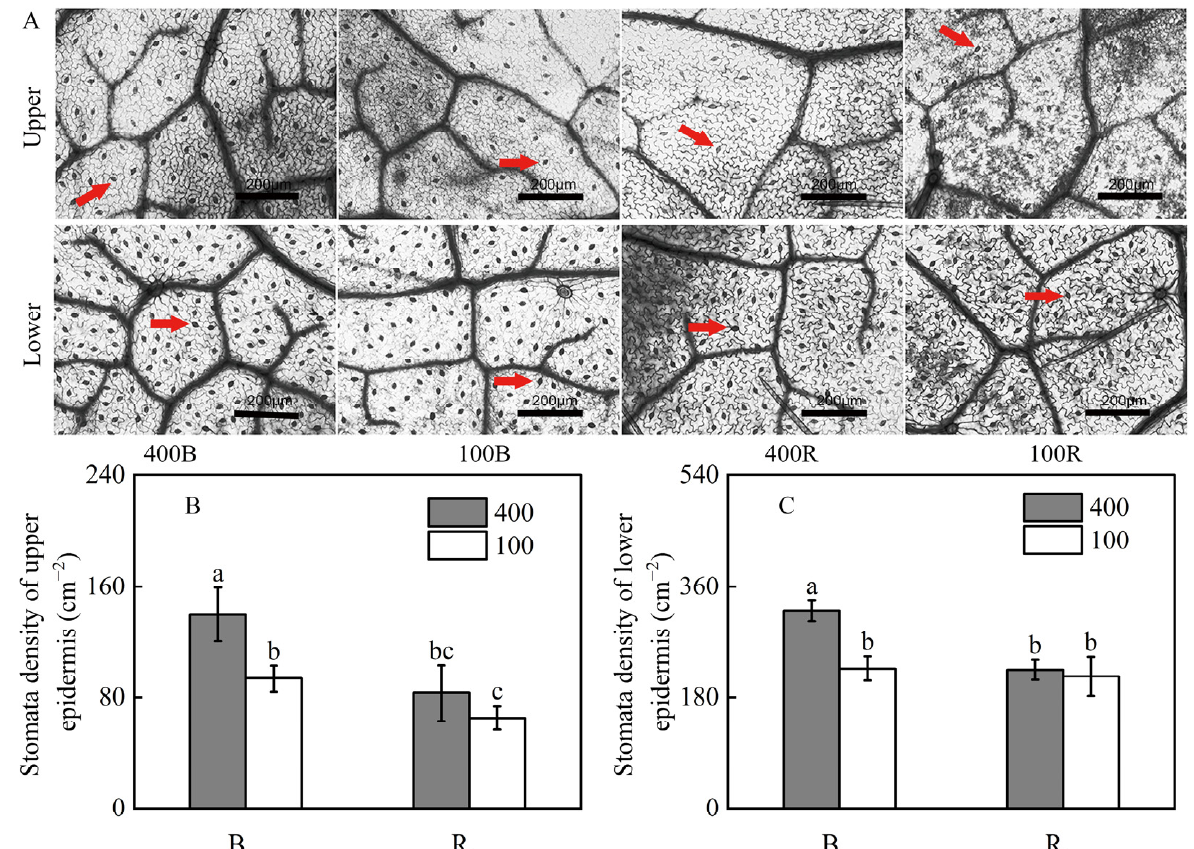
Figure 3. Stomatal density under different light intensities of blue and red light. ( A ) Photos; ( B ) the stomatal density of the upper epidermis; ( C ) the stomatal density of the lower epidermis . 400 B and 100 B denote the blue light with 400 µmol m − 2 s − 1 and 100 µmol m − 2 s − 1 , respectively. 400 R and 100 R denote the red light with 400 µmol m − 2 s − 1 and 100 µmol m − 2 s − 1 , respectively. Black spots indicate stomata. The stomatal density is higher when the number of black spots is higher. The mean ± SE is expressed in each value. Different lowercase letters indicate significant differences between treatments ( p ≤ 0.05).